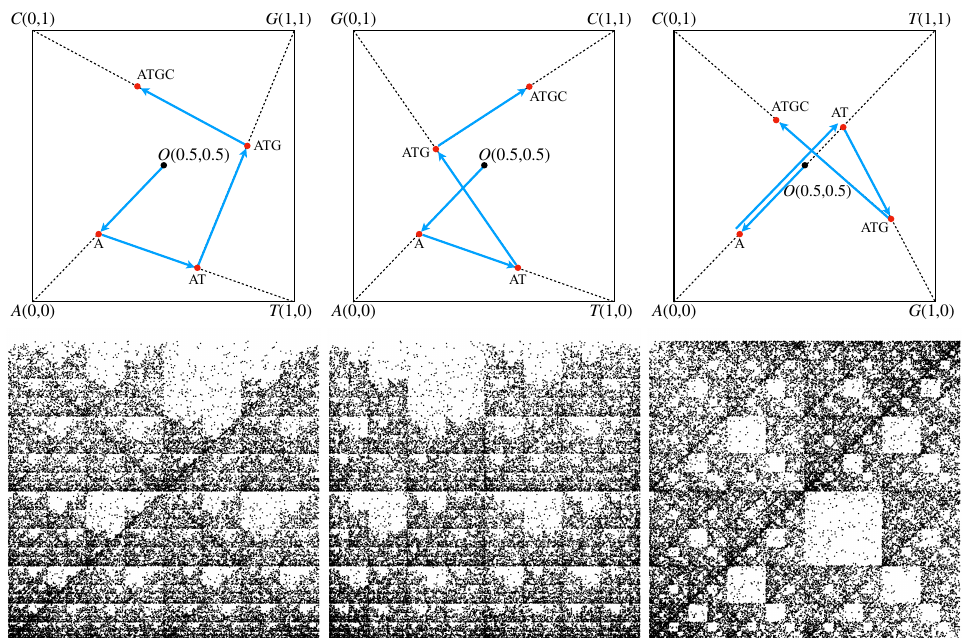
Figure 1. ( Upper row ) CGR for the short sequence “ATGC” in different configurations of the bases (see main text for details). ( Left ) RY configuration. ( Middle ) MK configuration. ( Right ) WS configuration. The arrow from nucleotide “A” to the sequence “AT” has been slightly shifted vertically for clarity. ( Lower row ) CGR for the H. cosmid g1346a094, GenBank ID: AC000362.1 (40,977 bp) in different configurations of the bases. ( Left ) RY configuration. ( Middle ) MK configuration. ( Right ) WS